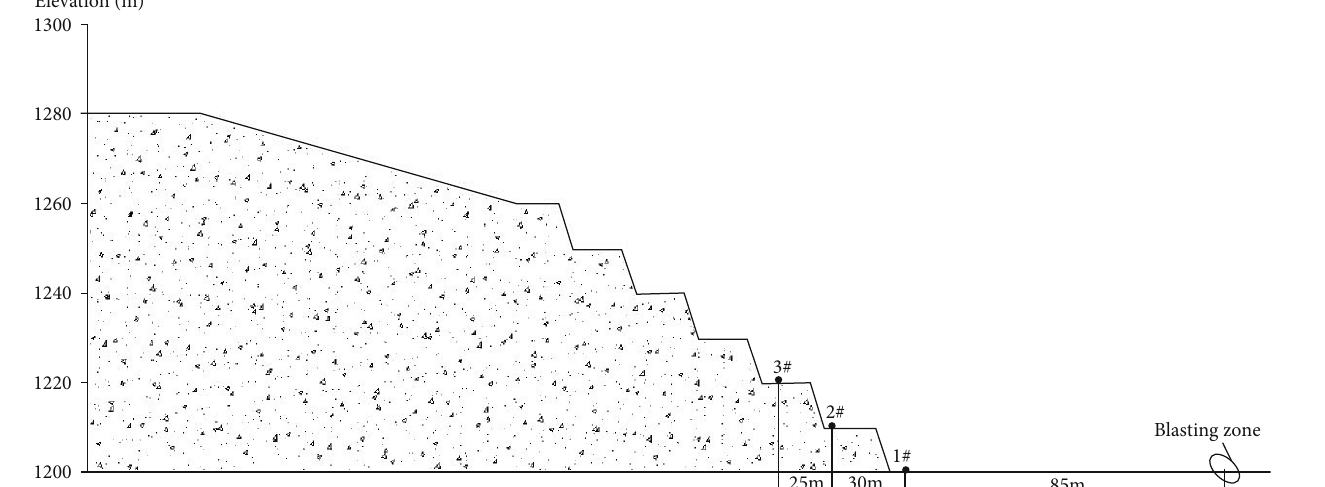
Figure 7: The schematic diagram of monitoring points arrangement.